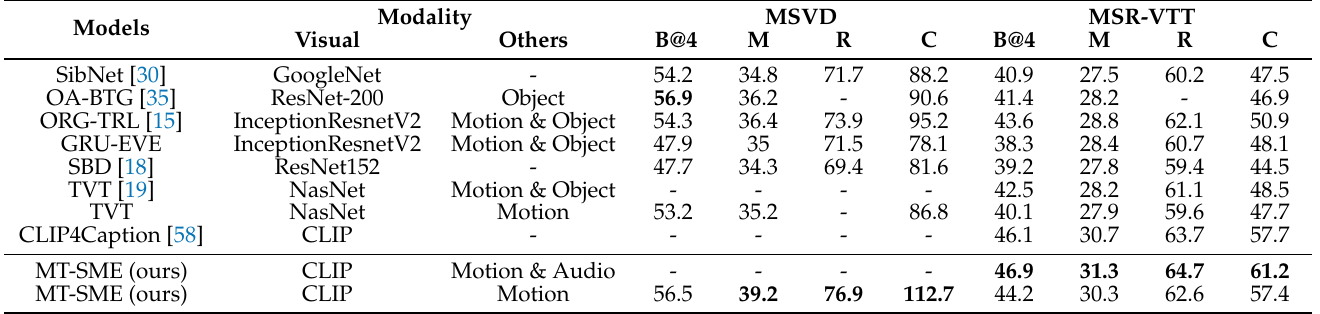
Table 1. Performance comparisons on MSVD and MSR-VTT benchmarks. The best results and corresponding features are listed. B@4 is short for Bleu@4, M is short for METEOR, R is short for ROUGE, and C is short for CIDEr. MT-SME is short for our model’s name—Multi-Task Stepwise Multimodal Encoder. The maximum value of each column is marked in